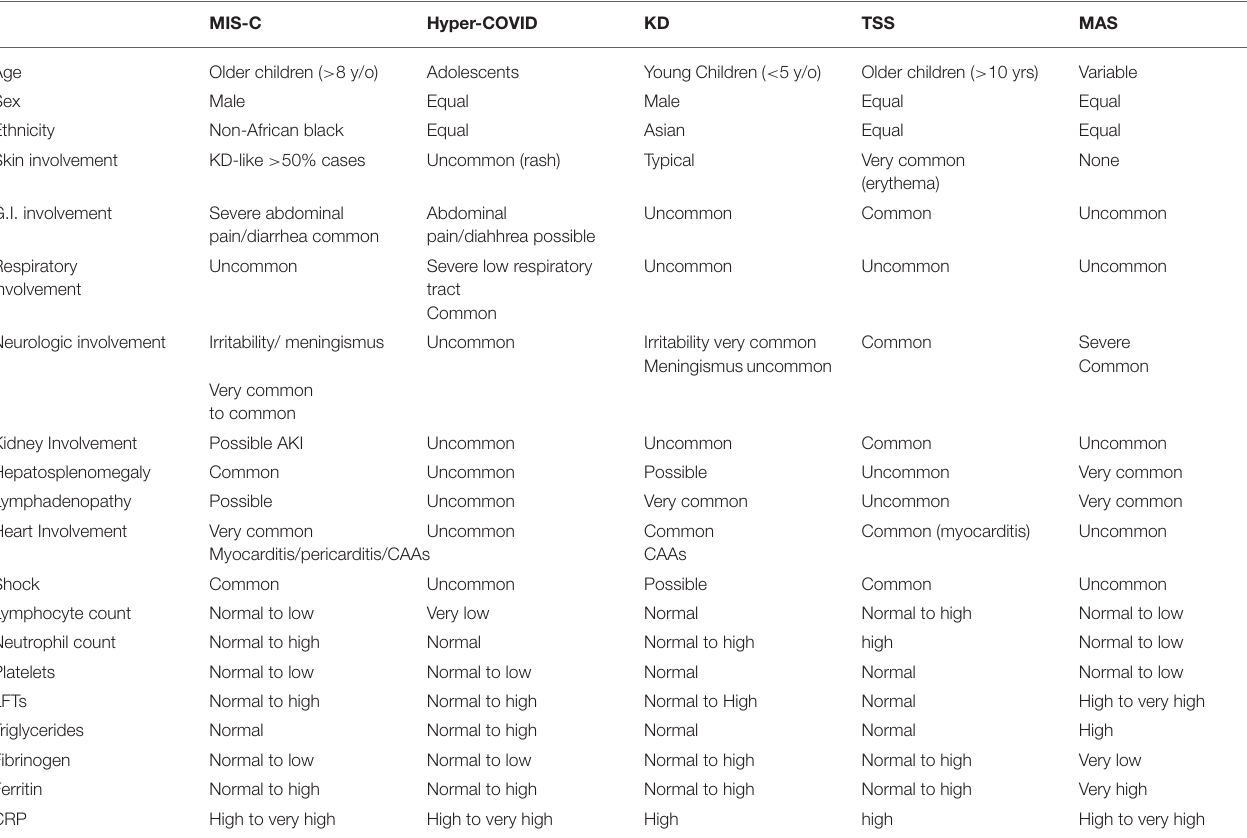
TABLE 1 | Main clinical and laboratory differences between MIS-C, Hyper-COVID, KD, TSS, and MAS (macrophage activation